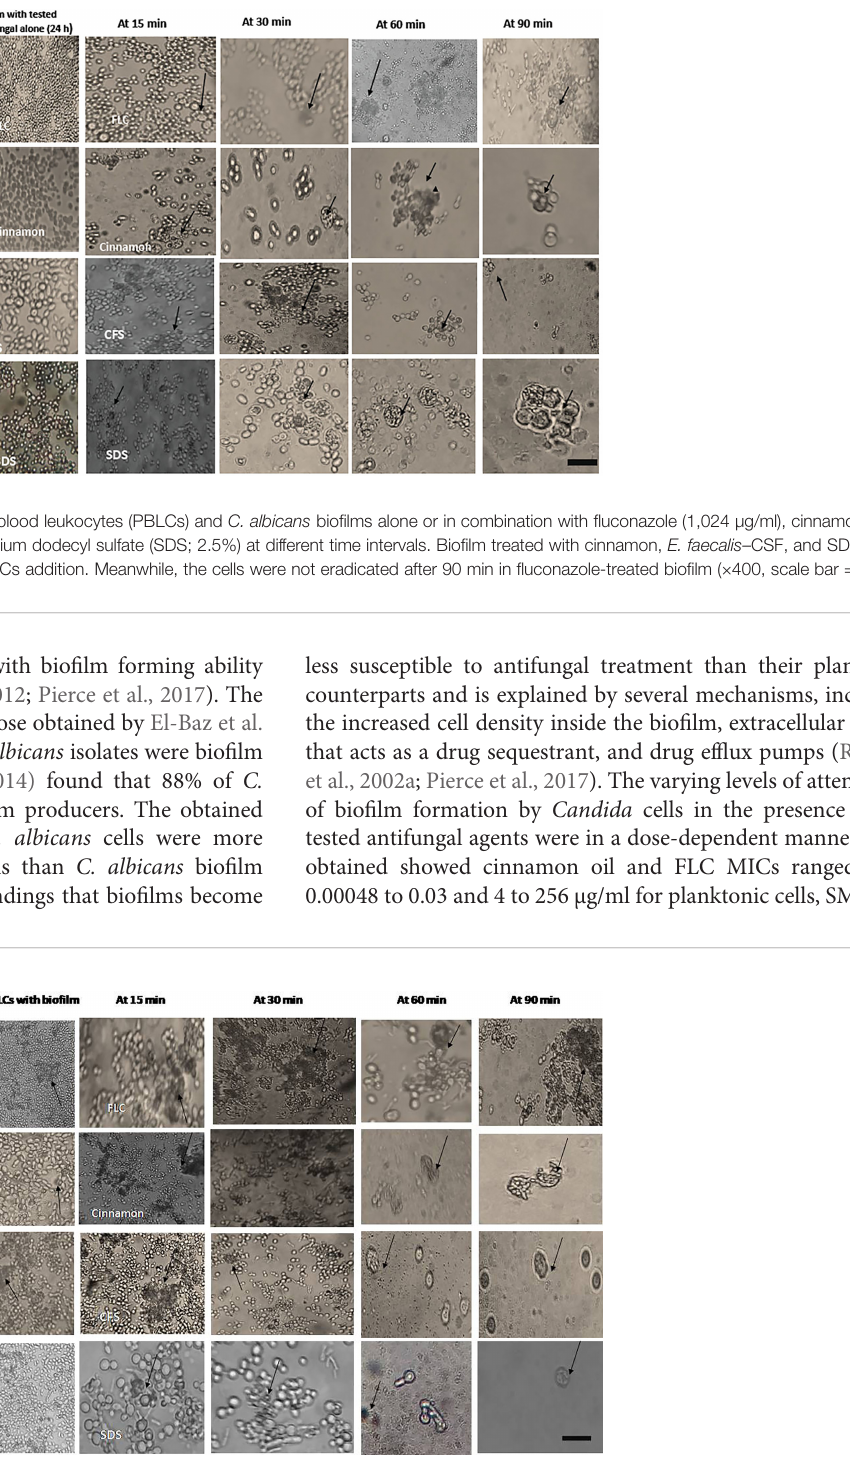
FIGURE 5 | Interaction between peripheral blood leukocytes (PBLCs) and 24-h preformed bio fi lms treated with the tested agents (in bio fi lm destruction testing): fl uconazole (1,024 µg/ml), cinnamon oil (4 µg/ml), E. faecalis – CFS (2 µg/ml), and sodium dodecyl sulfate (SDS, 2.5%). Additive effects between phagocytes and antifungal agents were observed. Bio fi lm clearance was detected at 15 – 90 min after PBLCs addition. Bio fi lms treated with cinnamon, E. faecalis – CSF, and SDS were effectively cleared within 60 min of PBLCs addition (×400, scale bar = 40 µm). Arrows refer to